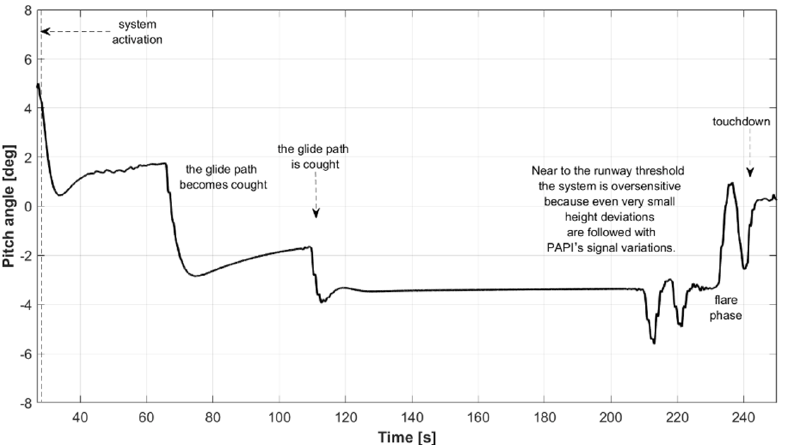
Figure 19. The number of both red and white PAPI lights identified by the vision system.